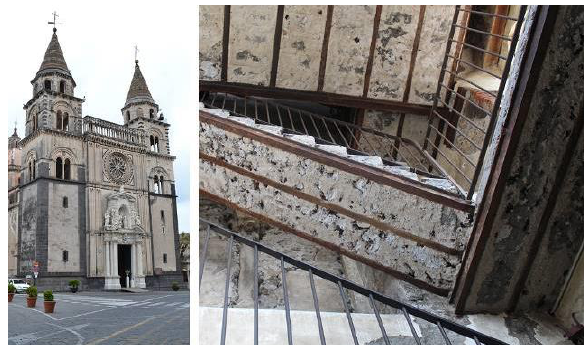
Figure 7. The bell towers of the Cathedral of Acireale (Ct). Floors, stairs and landings with NP iron beams.